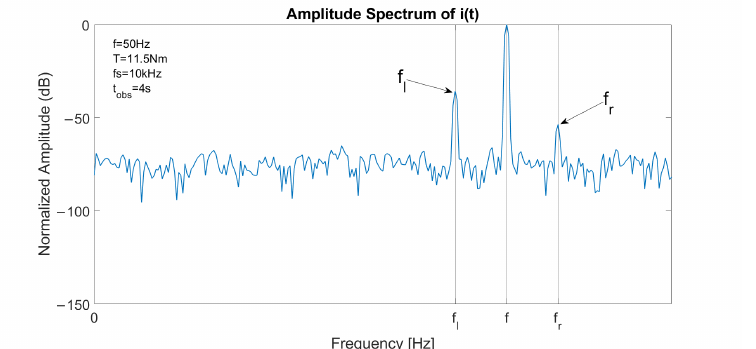
Figure 3. Spectrum of a stator current in case of one broken bar, constant speed at 1500 rpm and slip 6%, with fundamental component located at f , left sideband component located at f l = ( 1 − 2 s ) · f and right sideband component located at f r = ( 1 + 2 s ) · f .